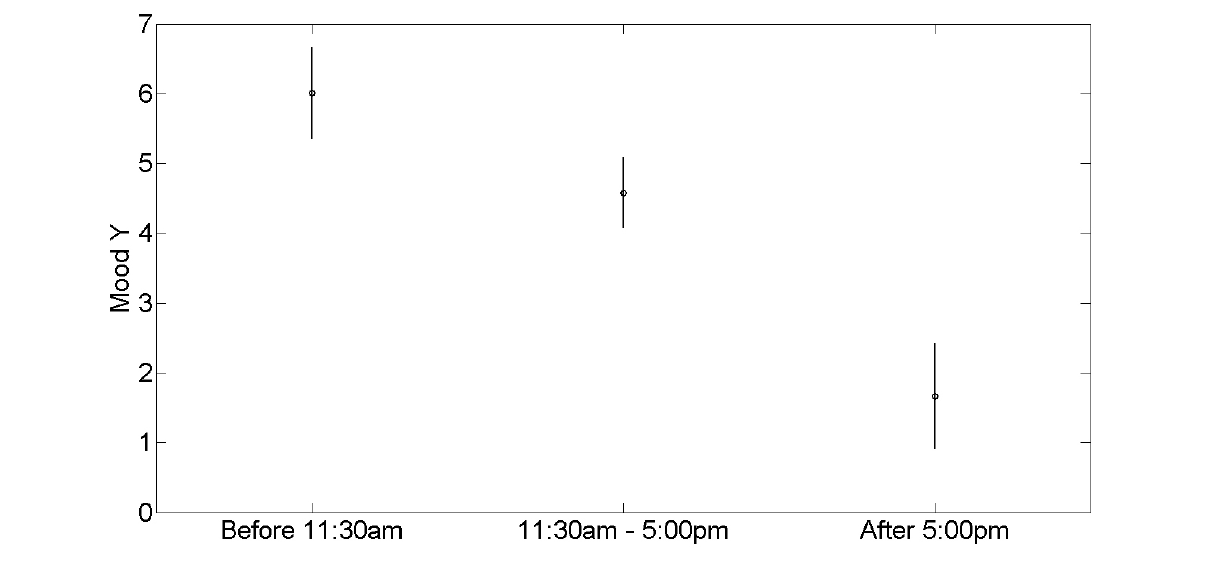
Figure 6. Progressive drop in Tobias’ energy through the day. The circles show the mean values in the diurnal segments indicated on the abscissa. Error bars show the 95% confidence limits on the means. Note that the total Mood Y range available to the user is [-7,